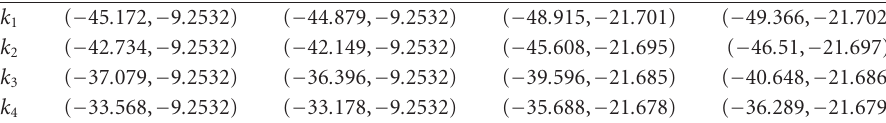
Table 4.3. The vertexes’ coordinates of k 1 , k 2 , k 3 , k 4